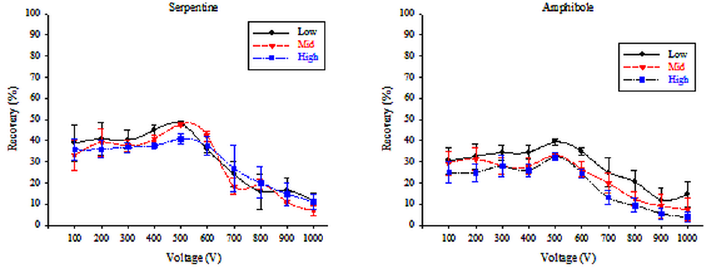
Fig 6. HY-DMA recovery according to asbestos type, concentration, and applied